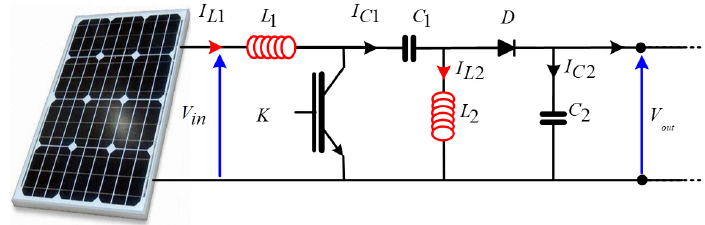
Figure 6. Electrical diagram of SEPIC